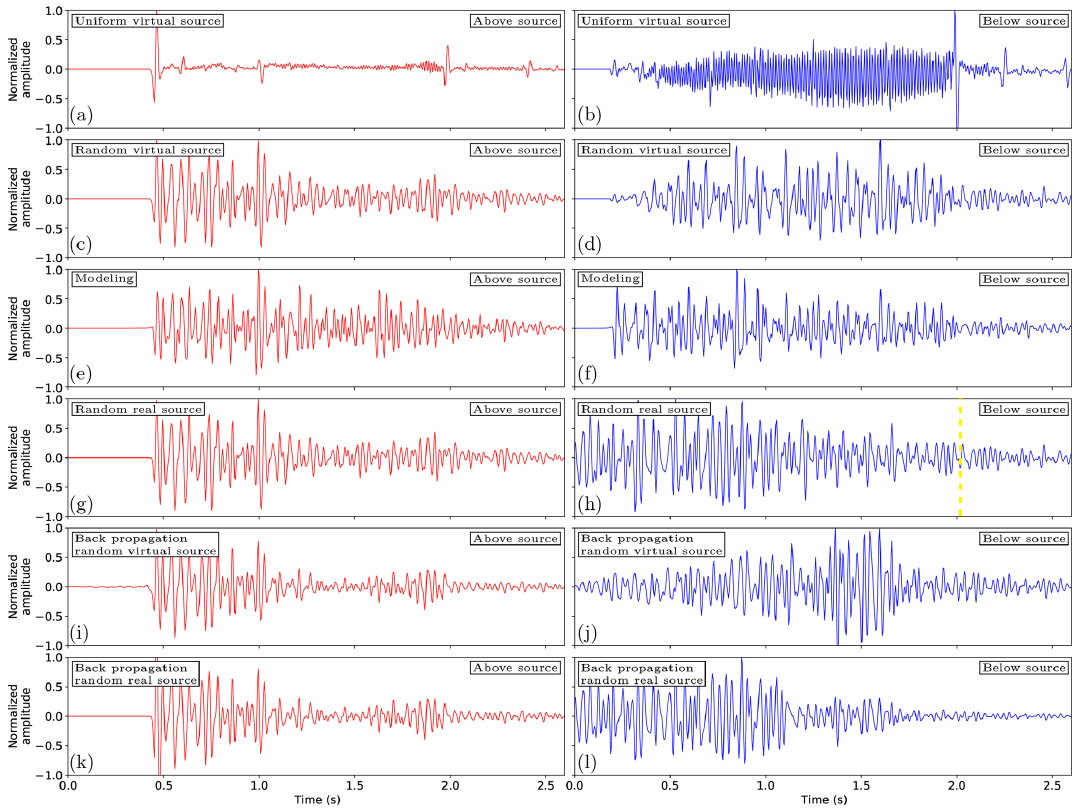
Figure 10. Traces of receivers in the subsurface at two locations, extracted from Fig. 9. In the left column, the receiver is located above the source and corresponds to the red dot in Fig. 9a, and in the right column it is located below the source and corresponds to the blue dot in Fig. 9a. (a–b) Response in the subsurface, retrieved using Eq. (21) for virtual receivers and virtual double-couple sources inclined at 45 ◦ with a uniform amplitude. (c–d) Similar to (a–b) using random amplitudes for the source. (e–f) Directly modeled wave field using the exact model from Fig. 5a and b and monopole point sources with a random amplitude. (g–h) Similar to (c–d) using a superposition of double-couple sources with random amplitudes using Eq. (22). The yellow line in (h) indicates the time after which the correct signal is retrieved. (i–j) Similar to (c–d) , but instead of using the homogeneous Green’s function retrieval, the back propagation using Eq. (23) is used for each source position. (k–l) Similar to (g–h) , but instead of using the Green’s function retrieval, the back propagation using Eq. (23) is used. All wave fields have been convolved with a 30Hz Ricker wavelet. Fig. 11b is used as an overlay to help indicate the region where scattering of the wave field is expected. The scattering takes place along regions where high amplitudes are present for the subsurface image, which indicates a match between the image and the homogeneous wave field. Aside from the direct arrival, there is also a coda present, which contains several events. The result is not as clean as the synthetic